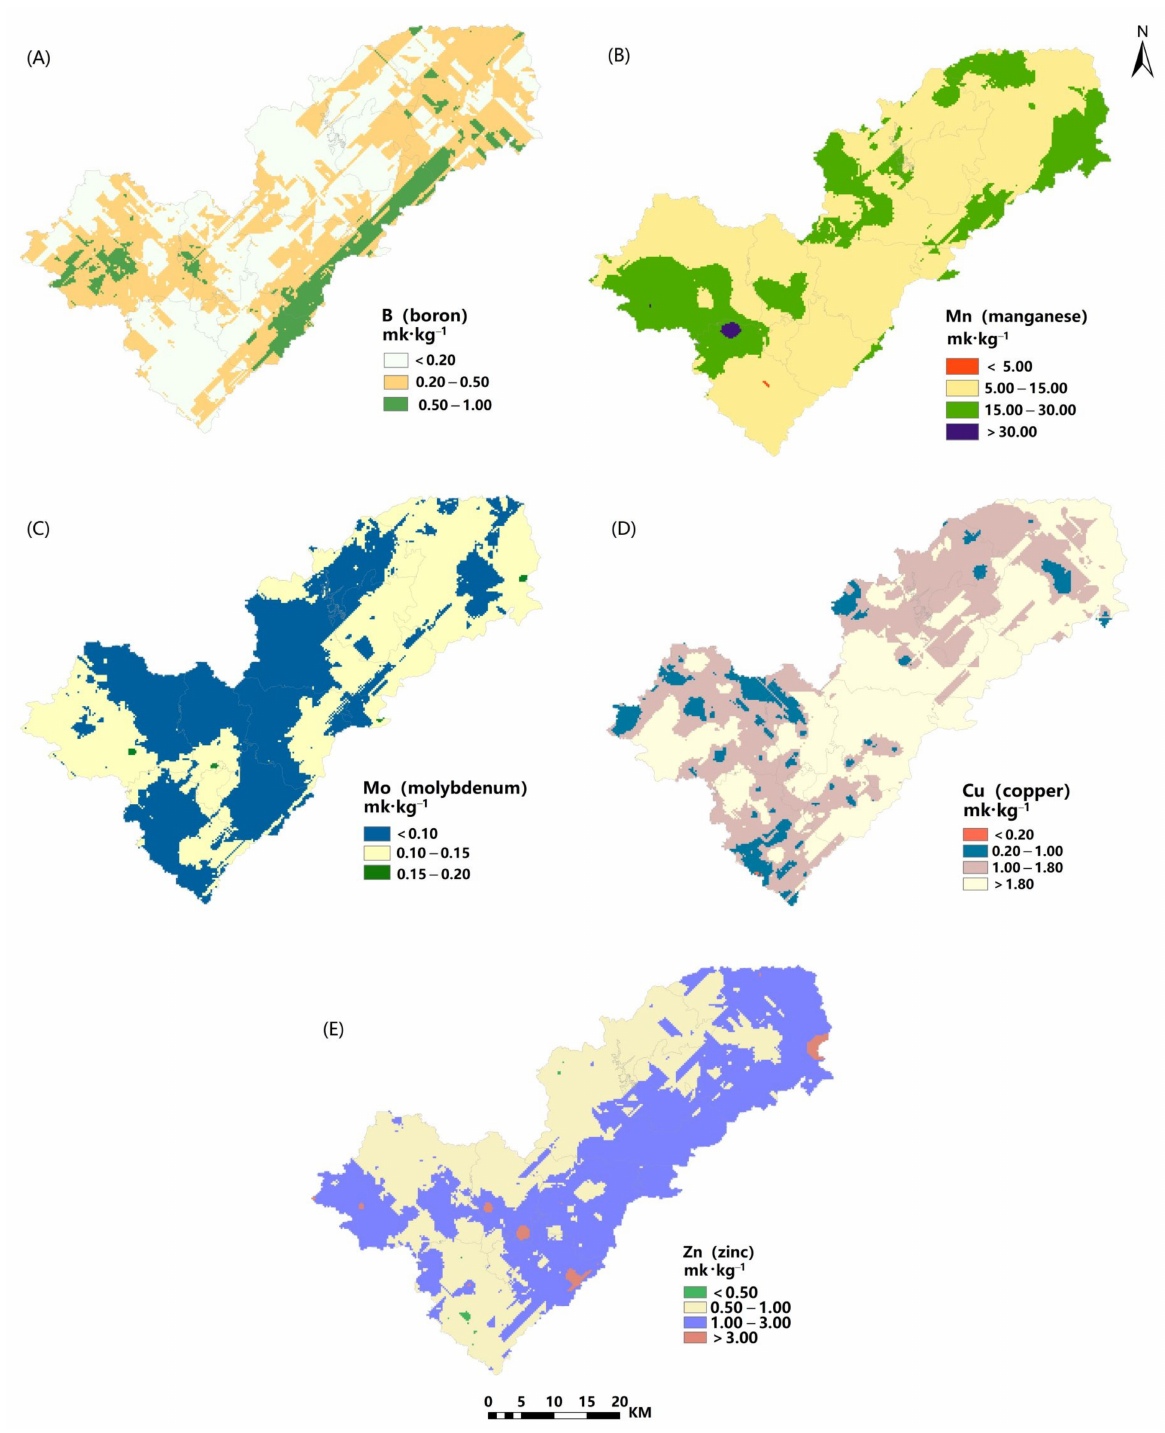
Figure 3. Spatial distribution of soil trace elements based on GWRK method: ( A ) boron, ( B ) man- ganese, ( C ) molybdenum, ( D ) copper, ( E ) zinc. Cu was generally present at high (43.67%) and extremely high (47.45%) levels, with the highest levels in the central and eastern plains. Zn was present at a moderate or high level, almost across the entire area (99.88% of the total area). In terms of spatial distribution, moderate levels (46.93%) were mainly distributed in the north, northwest, and southwest, and high levels were in the northeast, east, and western marginal areas, with some extremely high levels (1.02%) scattered throughout the southern